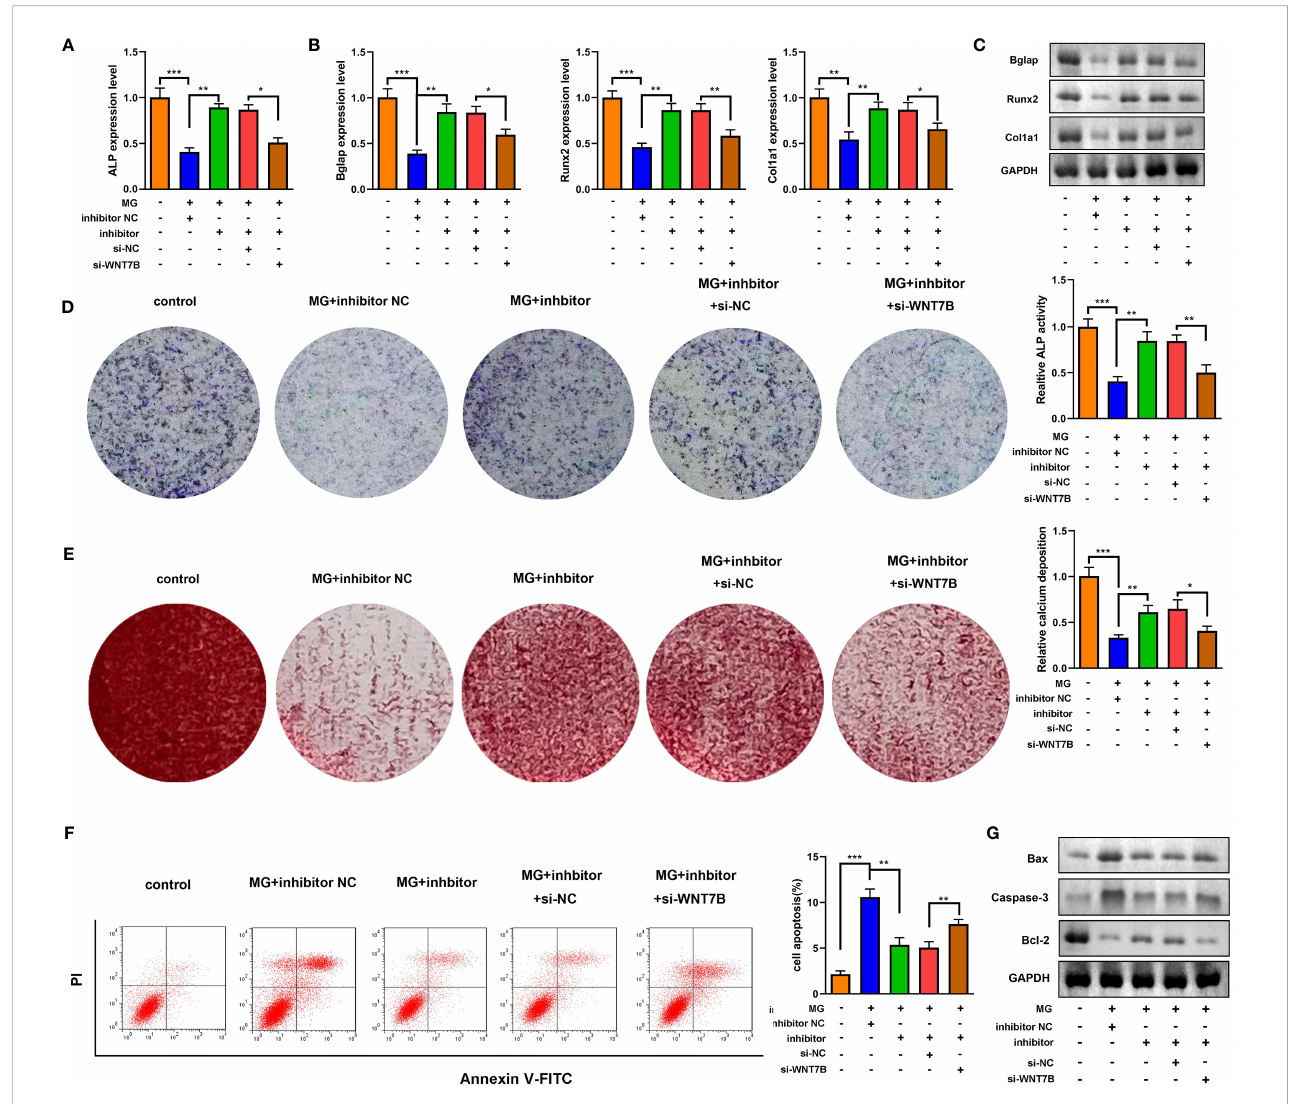
FIGURE 7 WNT7B was a negative regulator of miR-485-5p on the osteogenic differentiation. The MG-treated MC3T3-E1 cell was transfected with miR-485-5p inhibitor and si-WNT7B. (A) The expression of ALP was detected by RT-qPCR. (B) The expression of Bglap, Runx2, and Col1a1 was detected by RT-qPCR. (C) The protein expression of Bglap, Runx2, and Col1a1 was detected by Western blot. (D) The ALP activity of MC3T3-E1 cells. (E) The calcium deposit detected using Alizarin red staining. (F) The apoptosis of MC3T3-E1 cells detected using fl ow cytometry. (G) The protein expression of Bax, Caspase-3, and Bcl-2 detected using Western blot. * p < 0.05, ** p < 0.01, *** p <